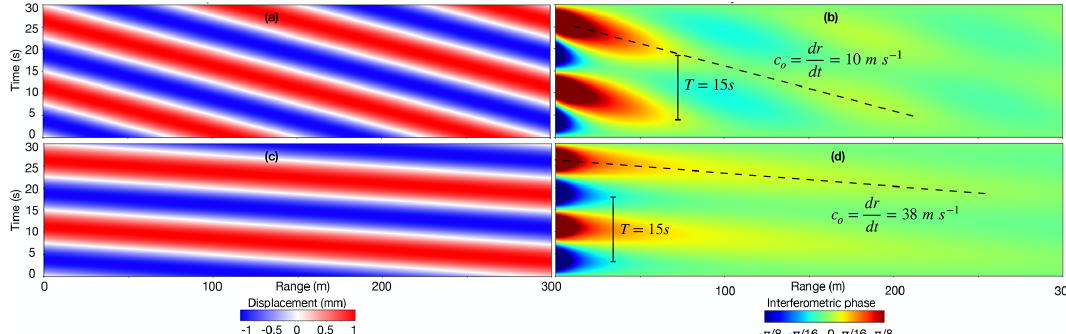
Figure 2. (a) Relative vertical elevation (i.e., elevation difference between the GPRI and the ice surface) for simulated periodic oscillations in 10m water depth ( T = 15s, A = 1mm, λ w = 150m) for LOS parallel to wave propagation and (b) associated synthetic interferogram. Panels (c) and (d) show results for the same simulated oscillations but with a LOS at 75 ◦ to the direction of propagation. The phase magnitudes of the patterns in panels (b) and (d) will differ based on the elevation of the GPRI system above the ice surface (here 6m).